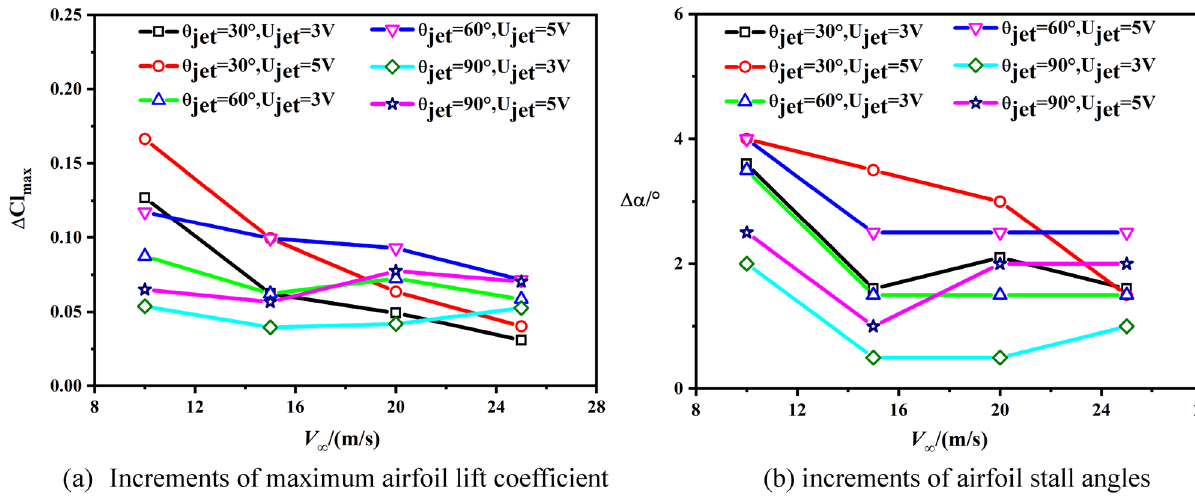
Figure 17. Influences with an increment of stall-incidence under different momentum